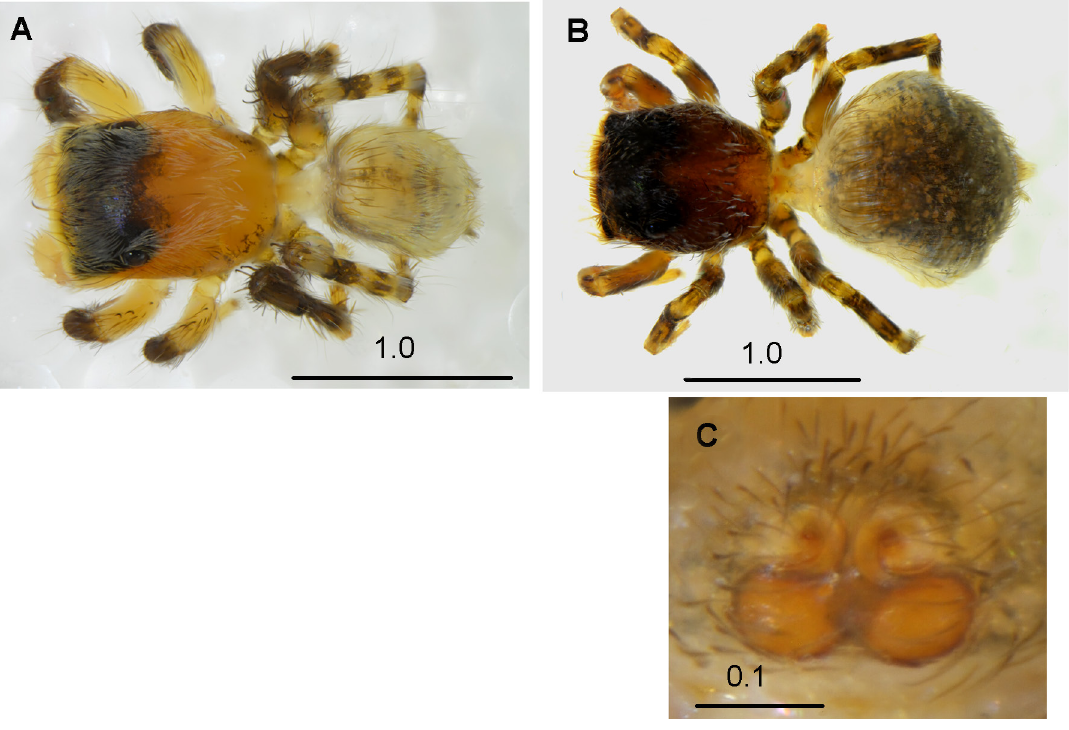
Fig. 64. Tanzania mkomaziensis (Wesołowska & Russell-Smith, 2000), ♂♀ (MNHN). A . Habitus of male, dorsal view. B . Habitus of female, dorsal view. C .